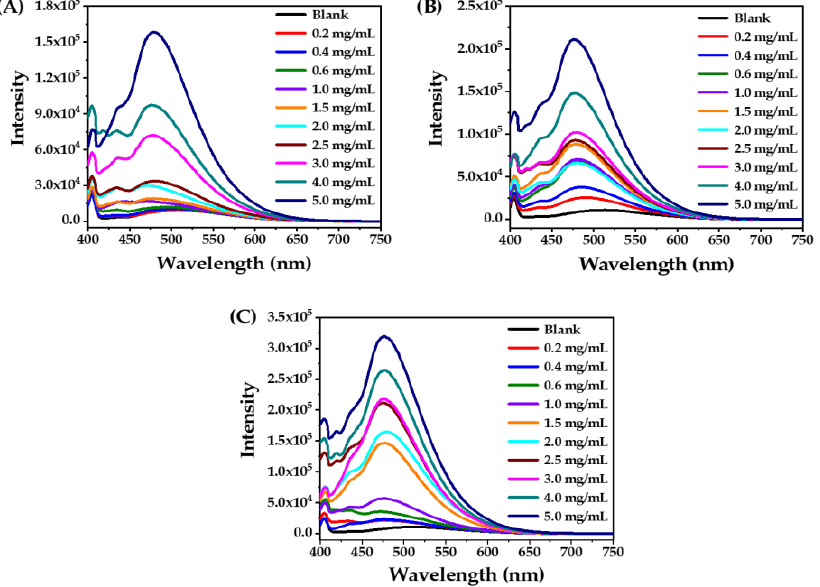
Figure 4. Luminescence spectra of ANS (1.0 × 10 − 5 mol/L) in aqueous solutions containing various concentrations of 2C8-Lys-Na ( A ), 2C10-Lys-Na ( B ), and 2C12-Lys-Na ( C ).